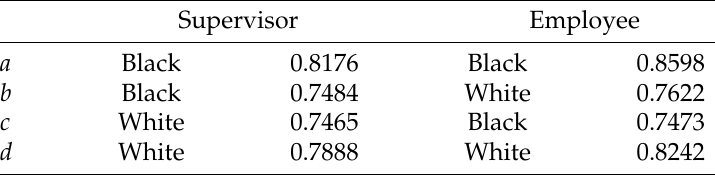
Table 7: Mean role-taking score by Experiment 2